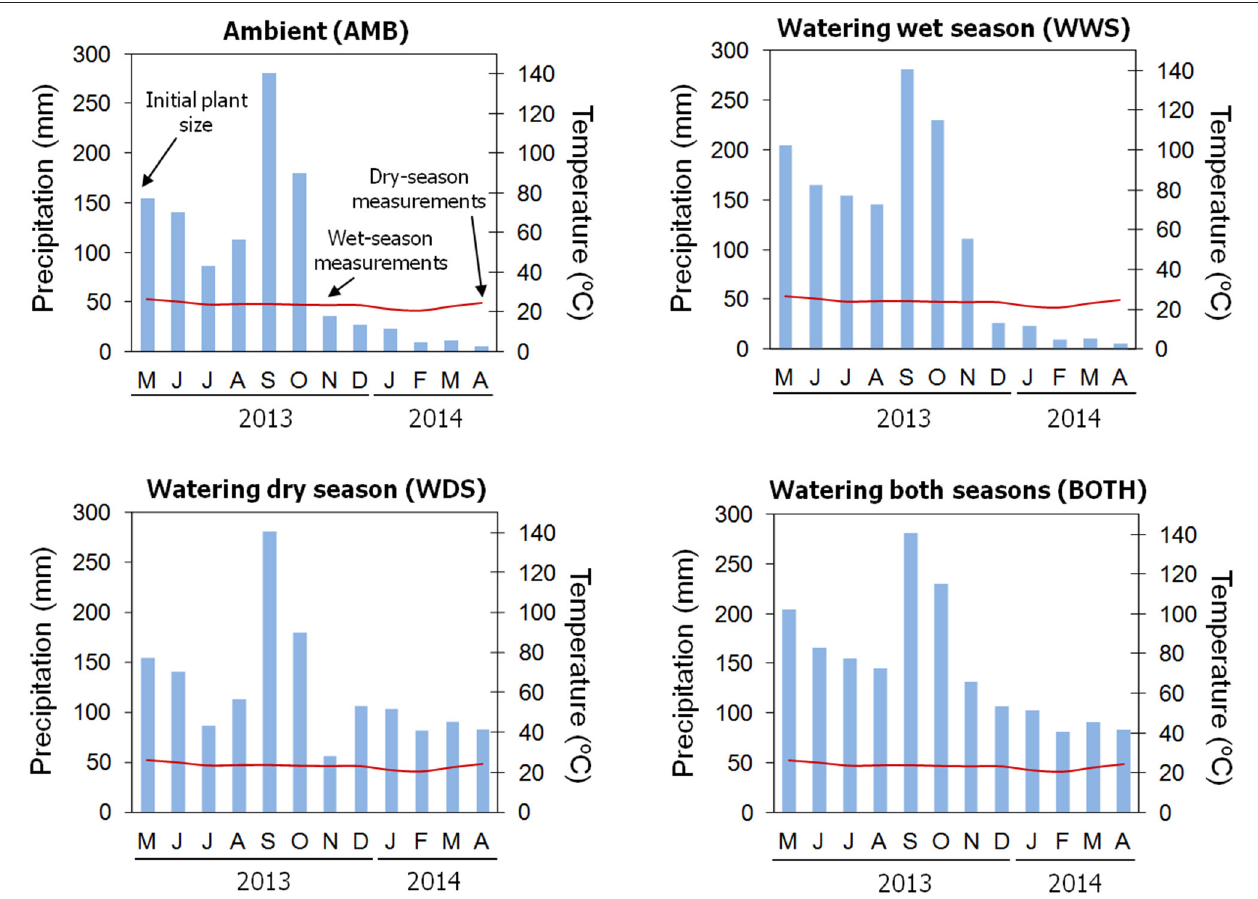
FIGURE 1 | Representation of the average monthly rainfall (blue bars) and temperature (red line) for the four precipitation regimes implemented in the common garden trial. Ambient values were obtained from the meteorological station located at the common garden. Estimated total precipitation per month was calculated based on the amount of water added in each watering treatment (see Materials and Methods). The time when growth and morpho-functional measurements were taken is indicated by arrows in the “AMB” figure.